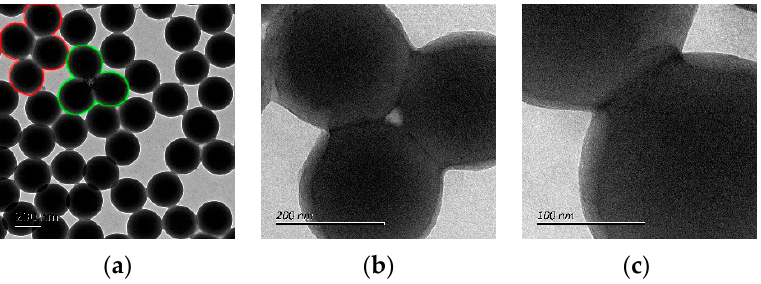
Figure 3. ( a ) TEM image showing variations in the morphologies of shells and cores for the higher concentration of spheres. ( b ) , ( c ) high-resolution TEM image of the inter-particle contact points.